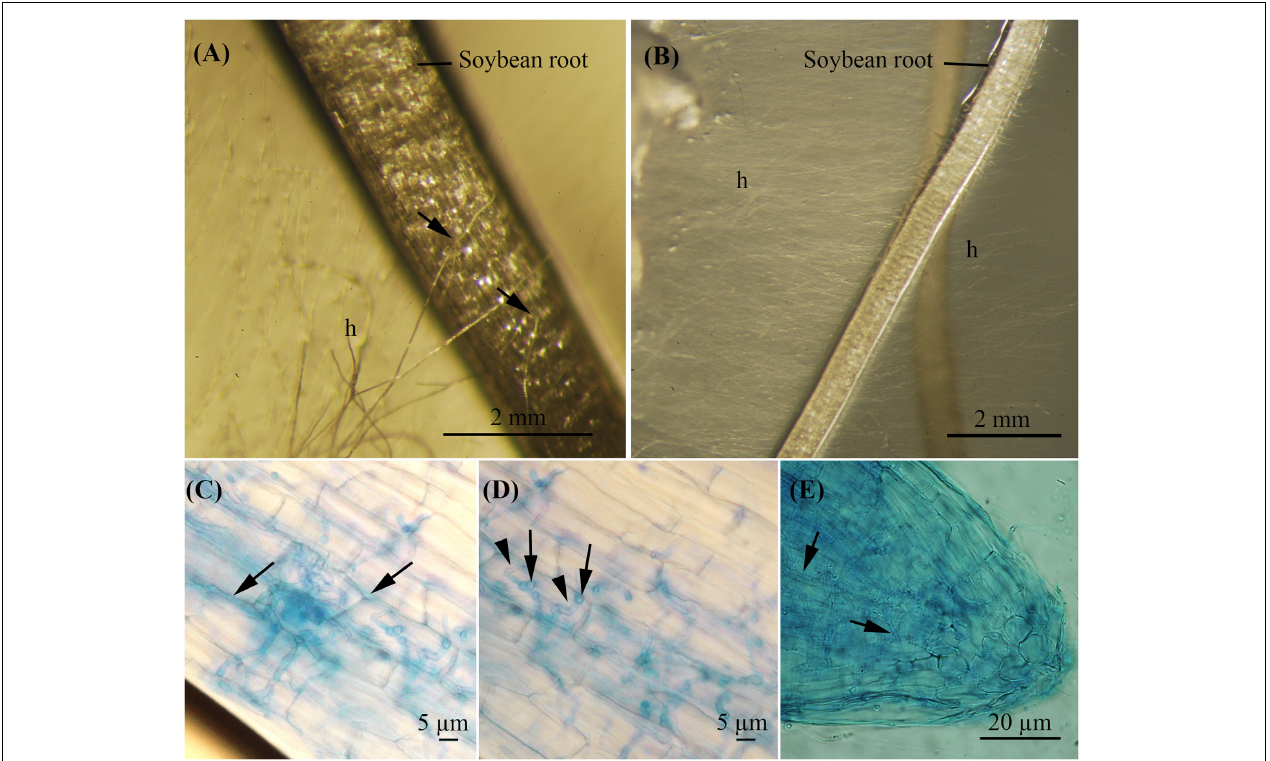
FIGURE 2 | Roots from soybean plantlets cultivated in vitro in the MDP in vitro culture system showing early infection stages by F. virguliforme observed under the stereo microscope (A,B) and under the microscope (C–E) . (A) Fungal hyphae contacting the host root surface 2 days after inoculation of the pathogen (soybean plantlet of 17-days-old). Bar = 2 mm. (B) Hyphal development 4 days after inoculation of the pathogen (soybean plantlet of 19-days-old). Bar = 2 mm. (C–E) Soybean roots stained with Trypan blue 0.2%. (C) Intercellular growth of F. virguliforme hyphae. Bar = 5 µ m. (D) Swollen and pigmented invasive structures (black arrow), intracellular growth of hyphae (arrowhead). Bar = 5 µ m. (E) Hyphae in the tip roots zone. Bar = 20 µ m.